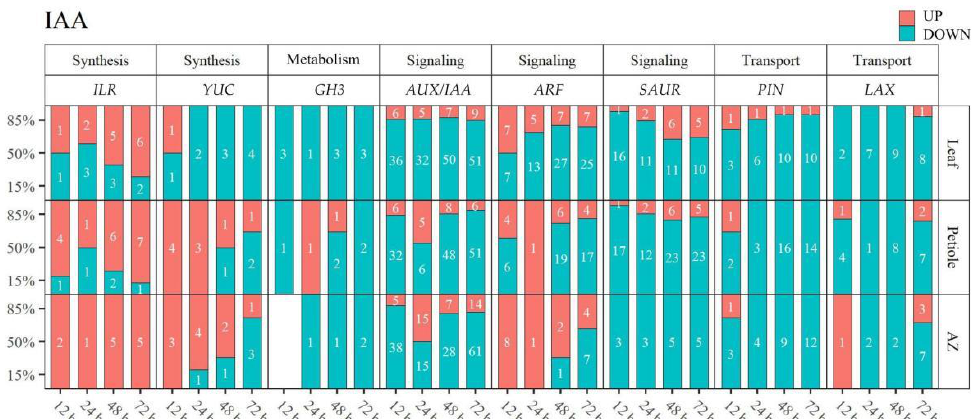
Figure 8. TDZ regulates the gene expression of IAA metabolism, transport, and signal. DEGs were determined between 12 h and 0 h, 24 h and 0 h, 48 h and 0 h, 72 h and 0 h, respectively. The DEGs were controlled by FDR<5% and |log2Fc|≥1. White digits indicate the gene num bers.